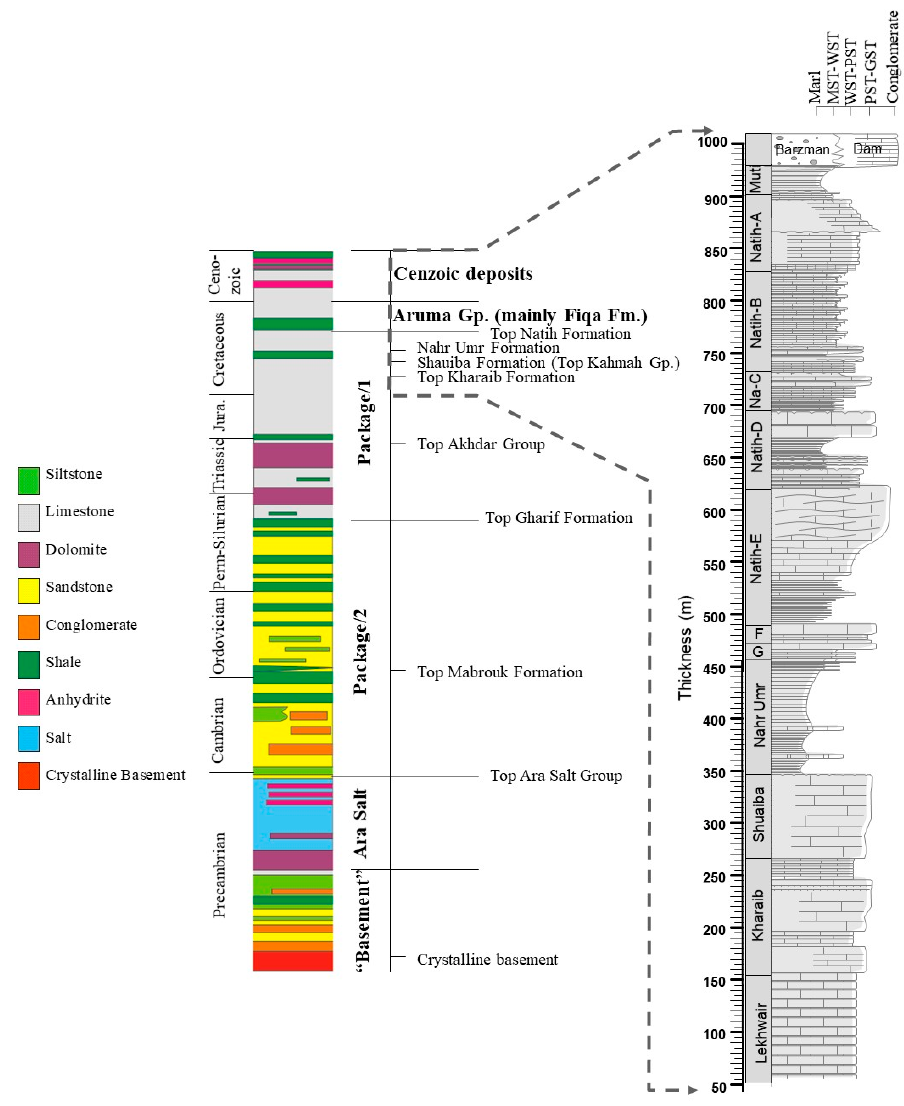
Figure 5. On the left is a simplified stratigraphical column of the five main mechanical packages (Aruma and Tertiary deposits, package / 1, package / 2, Ara Salt and basement) of Oman. The “basement” is considered to be all the units below Salt. The column also marks the position of the interpreted horizons in the seismic sections. On the right , a stratigraphic column based on the outcrops of the Barzaman conglomerate (with the interfingering formation of Dam limestone.), Muti, Natih, Nahr Umr, Shuaiba, Kharaib and Lekhwair Formations.